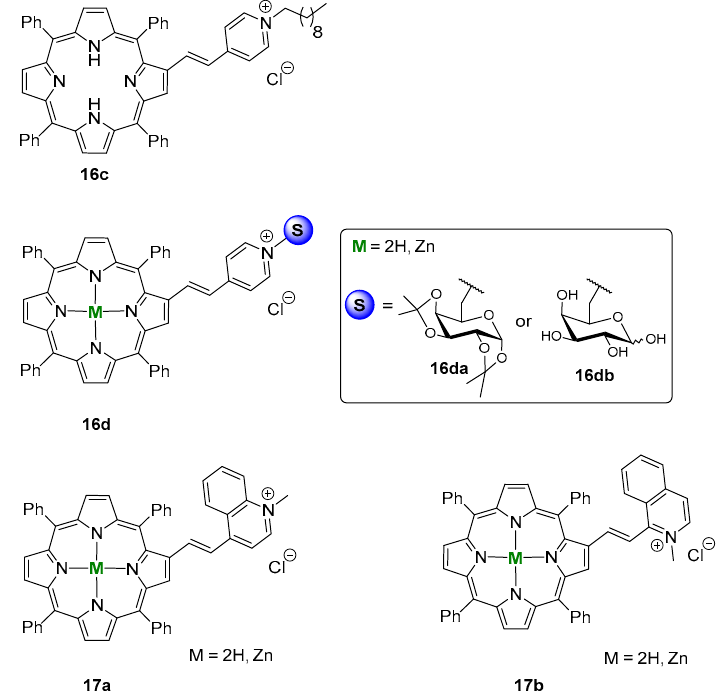
Figure 7. β -Vinylpyridinium- and β -vinylquinolinium- meso -tetraphenylporphyrin derivatives [103].